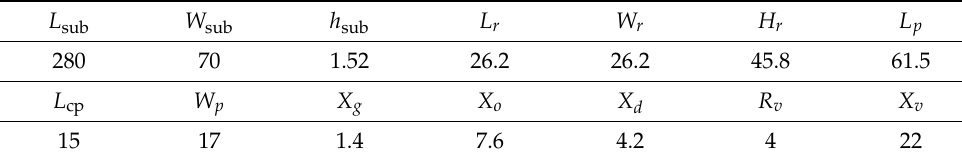
Table 1. Geometrical parameters of DRA array (unit: mm).